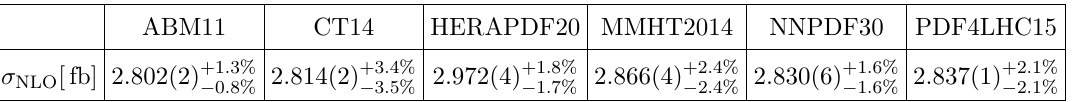
Table 1 . Cross section of the EW production process for di(cid:11)erent PDF sets and associated PDF uncertainties. The factorization and renormalization scale are set equal to (cid:22) F = (cid:22) R = Q i